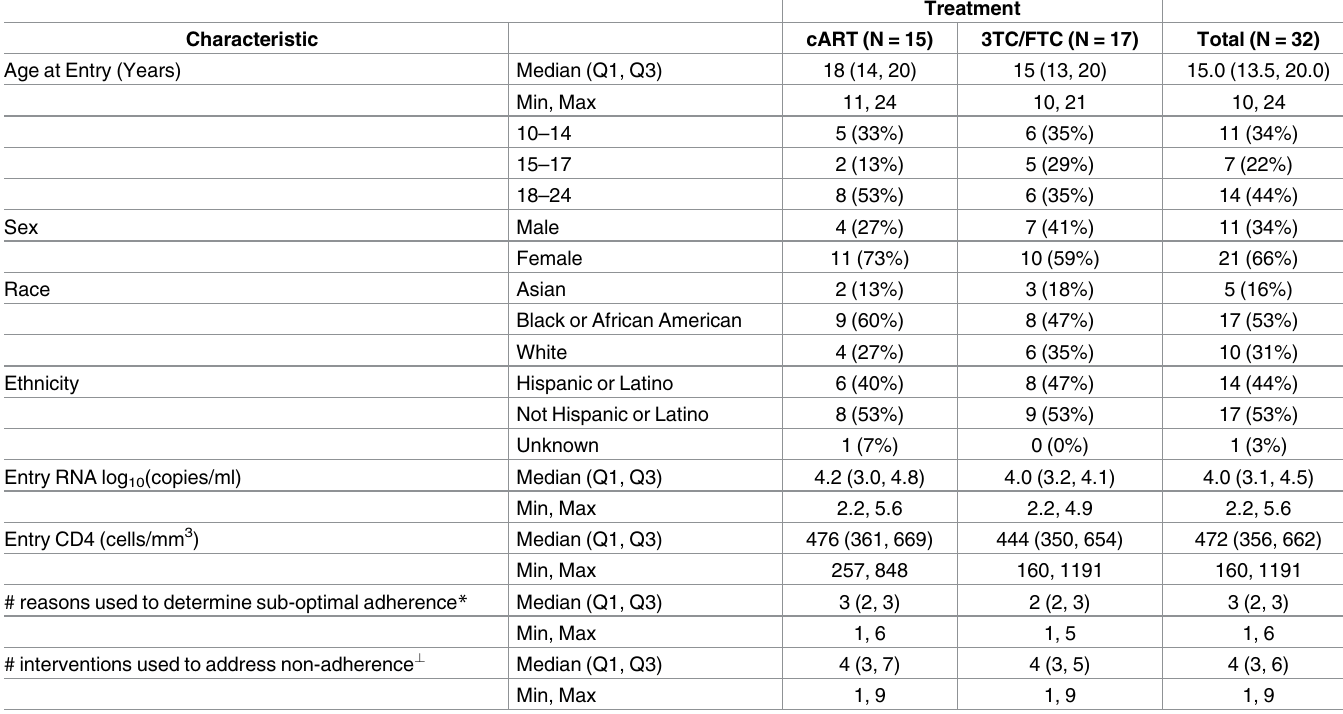
Table 1. Baseline characteristics of participants enrolled in